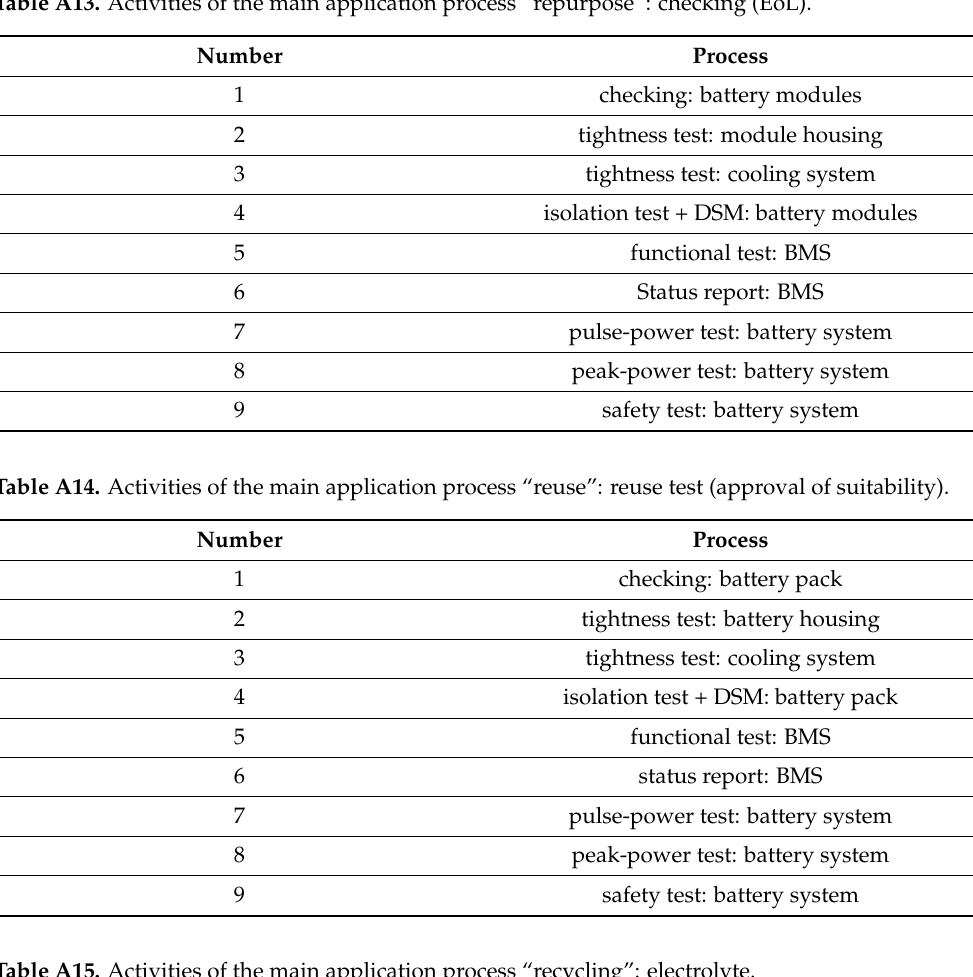
Table A15. Activities of the main application process “recycling”: electrolyte.